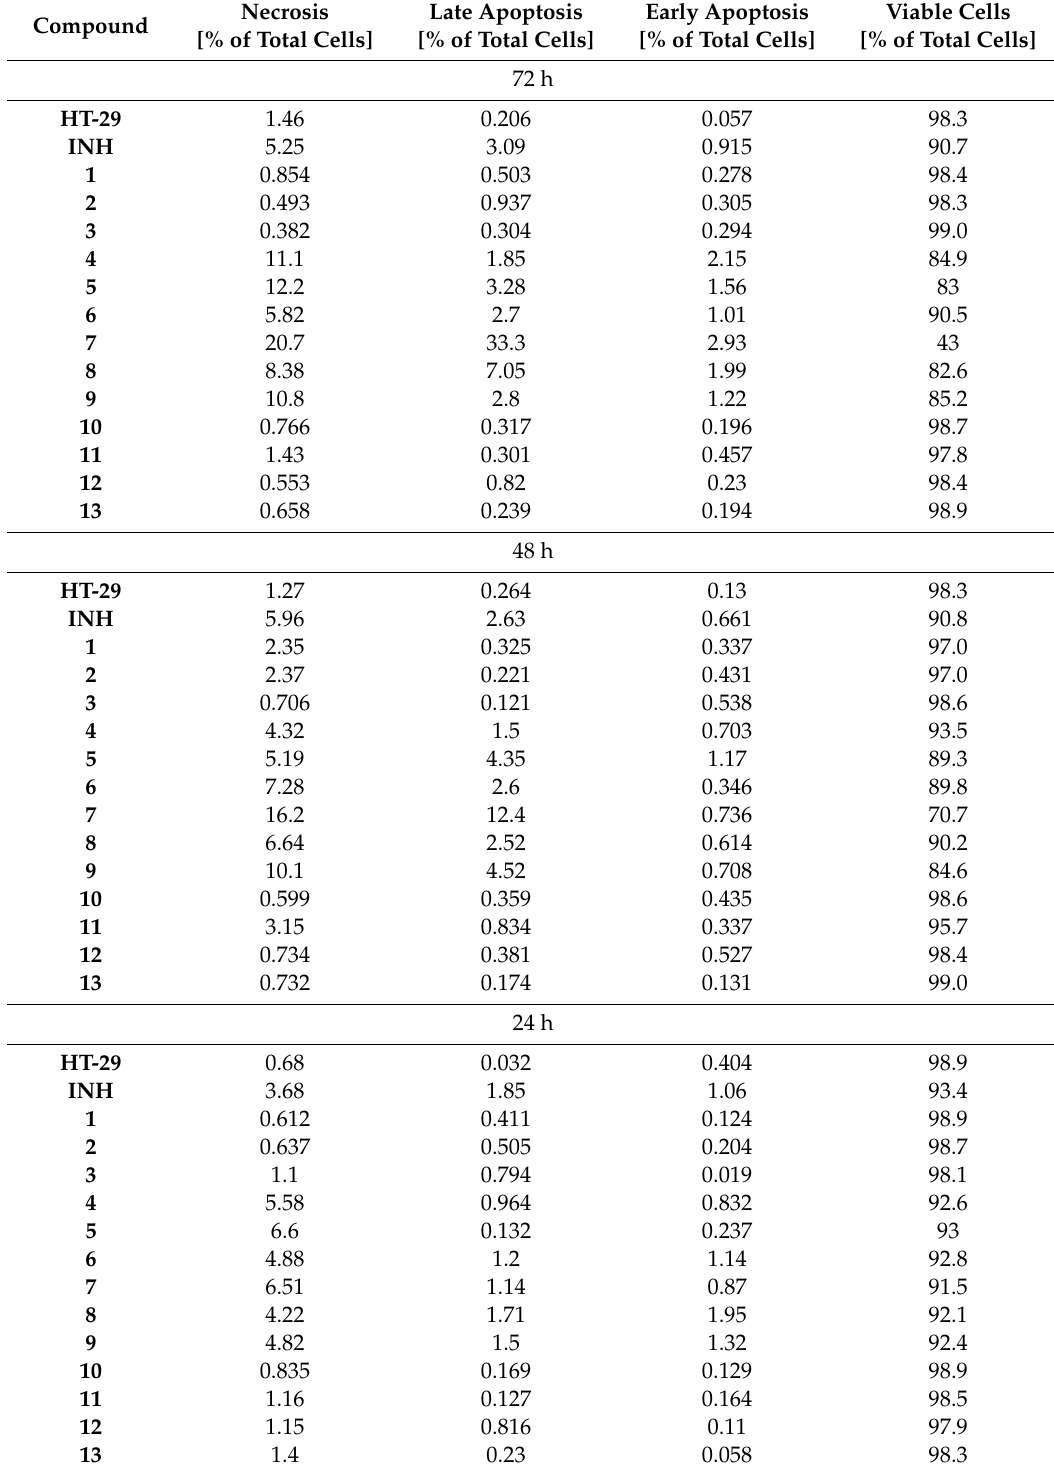
Table 4. Apoptosis induction by the new isoniazid derivatives in eukaryotic